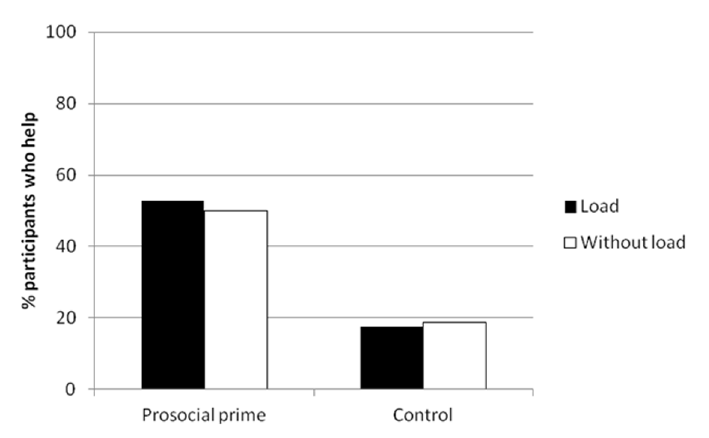
Figure 2. Percentage of participants who helped in all four